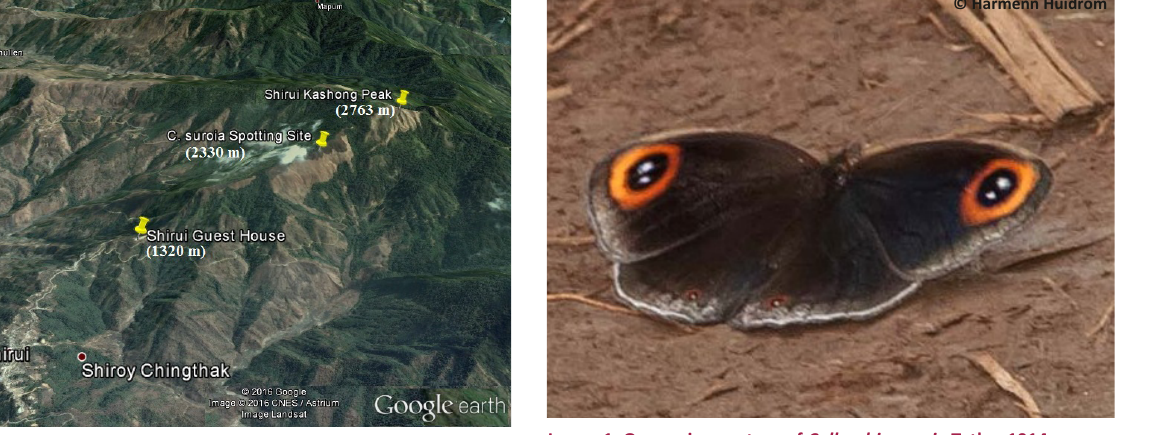
Figure 2. Google Earth map showing the observation site of Callerebia suroia Tytler, 1914 at Shirui Kashong Peak, Ukhrul District,